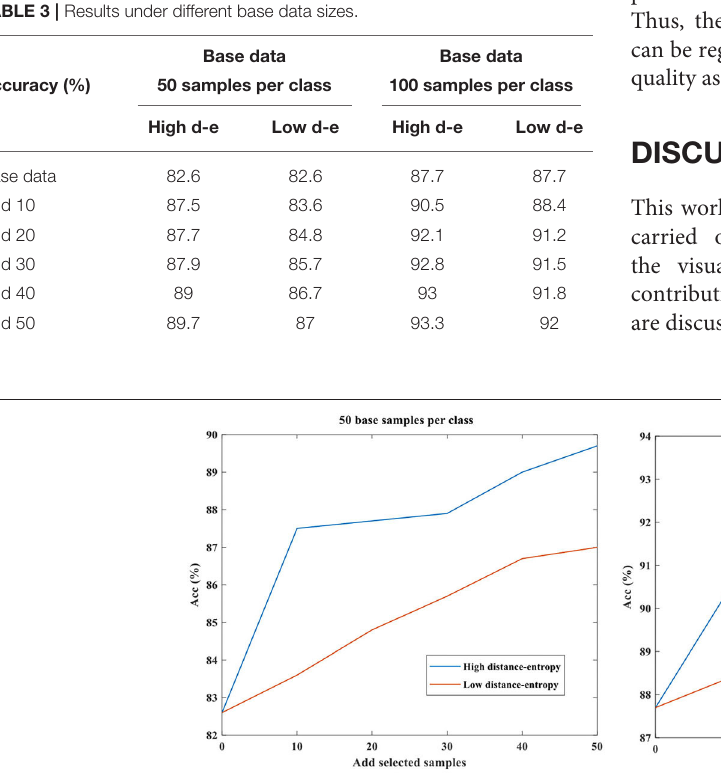
FIGURE 6 | The testing accuracy under different base data